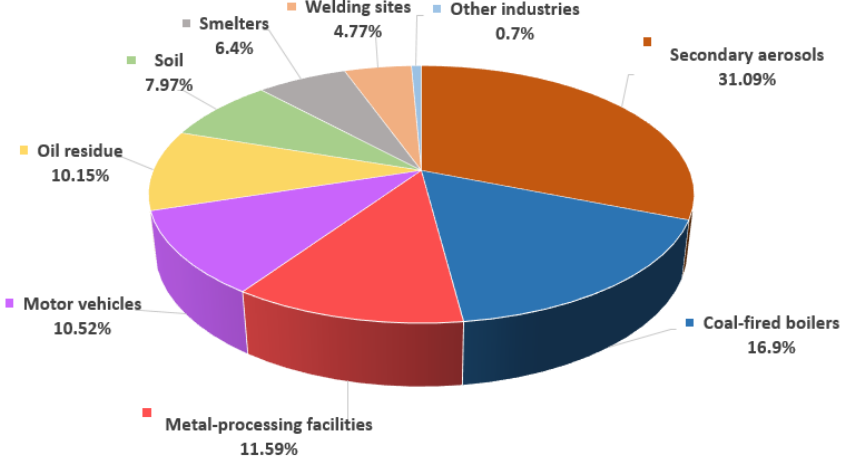
Figure 4. Contribution (%) of each identified source to PM 2.5 pollution.